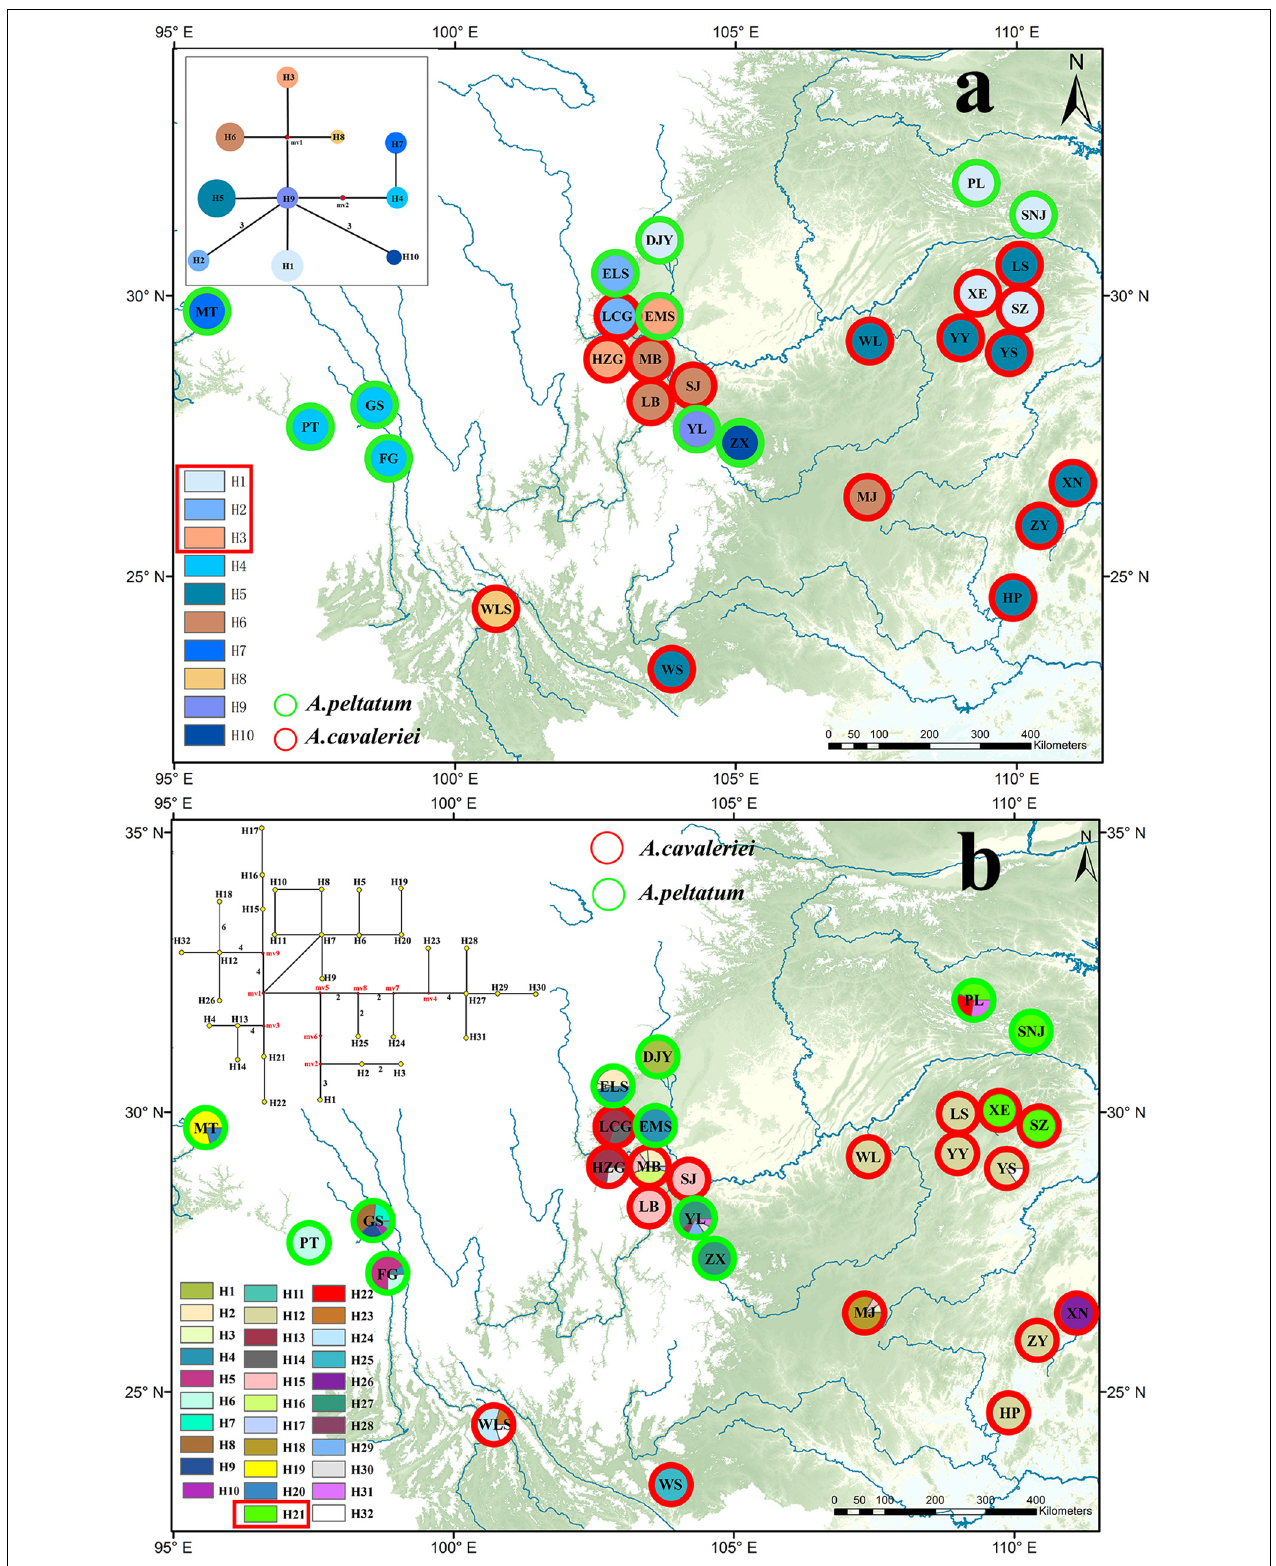
FIGURE 4 | The distribution maps and network analyses of chlorotypes ( psb A- trn H, a ) and ribotypes (ITS, b ). The haplotypes circled with red rectangle are shared by the two morphospecies.